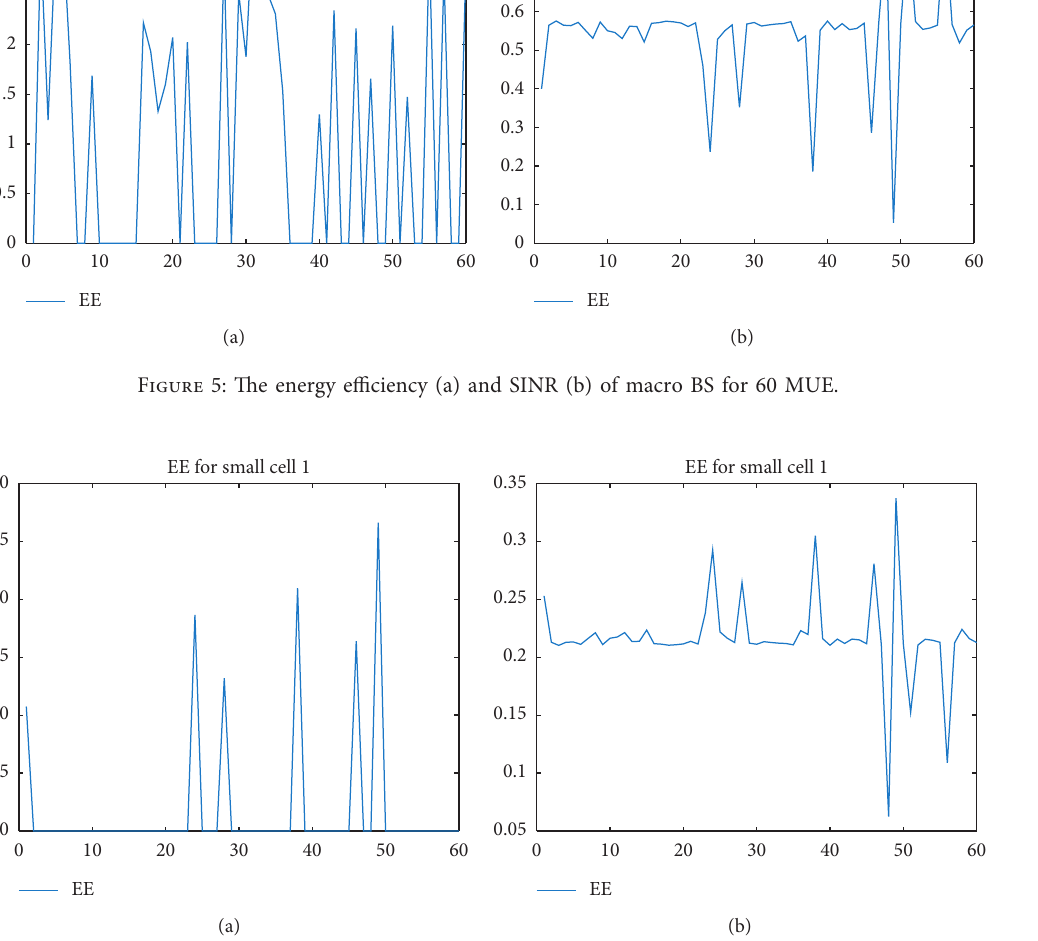
Figure 6: The energy efficiency (a) and SINR (b) of small BS 1 for 60